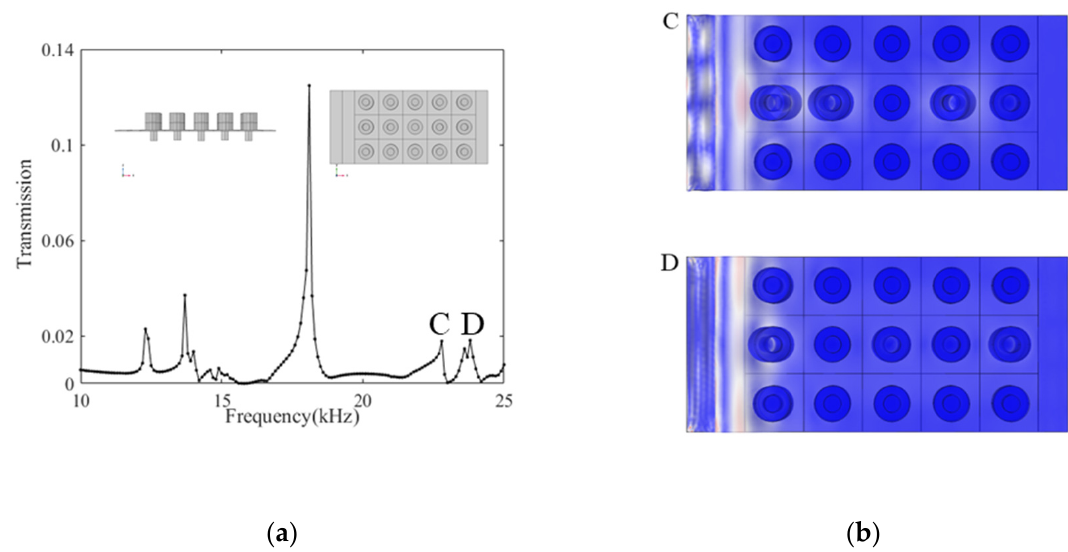
Figure 12. Schematic representation of a single-channel wavelength multiplexer. ( a ) The transmission spectrum of anti- symmetric Lamb waves when the FR in the waveguide FR (C) = 46.67% and FR (D) = 50%; ( b ) displacement field distribution at two narrow-band frequencies C and D.